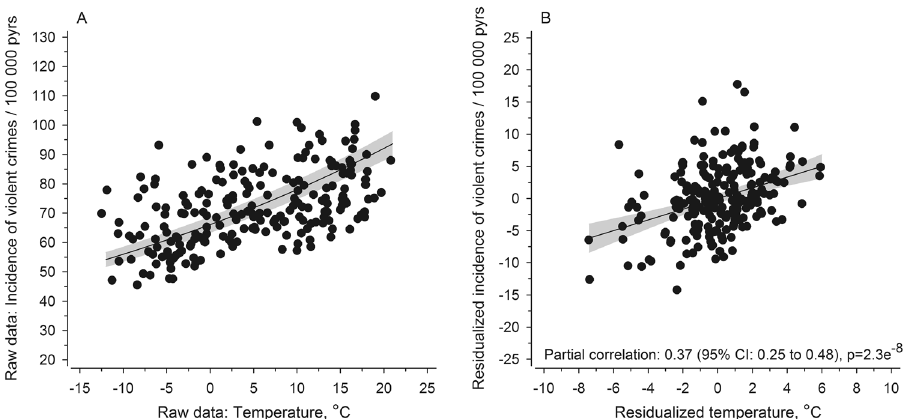
Figure 2. Panel A: The correlation between the monthly ambient temperature and monthly violent crime rate per 100,000 person years in Finland between January 1996 and December 2013 (r = 0.51, N = 216, p = 7.6 × 10 − 16 ). Panel B: Residualized (controlled for seasonality and time trends) relationship between violent crime and temperature